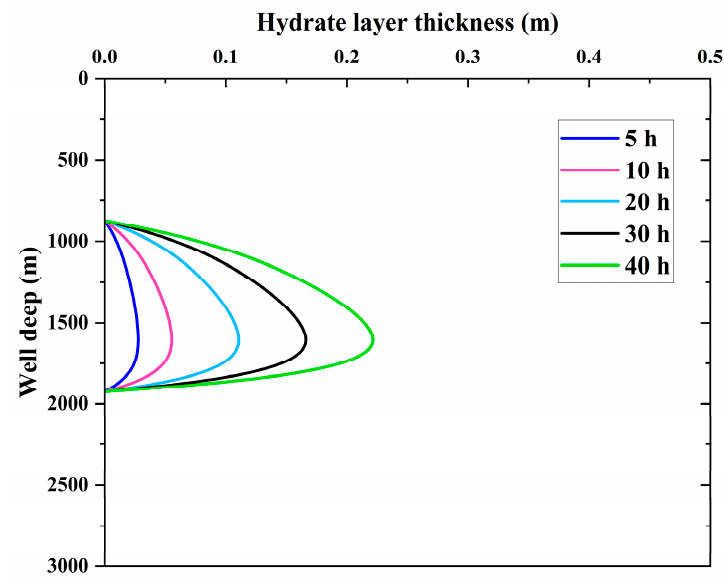
Figure 8. Variation of hydrated layer thickness with time under kill well condition.